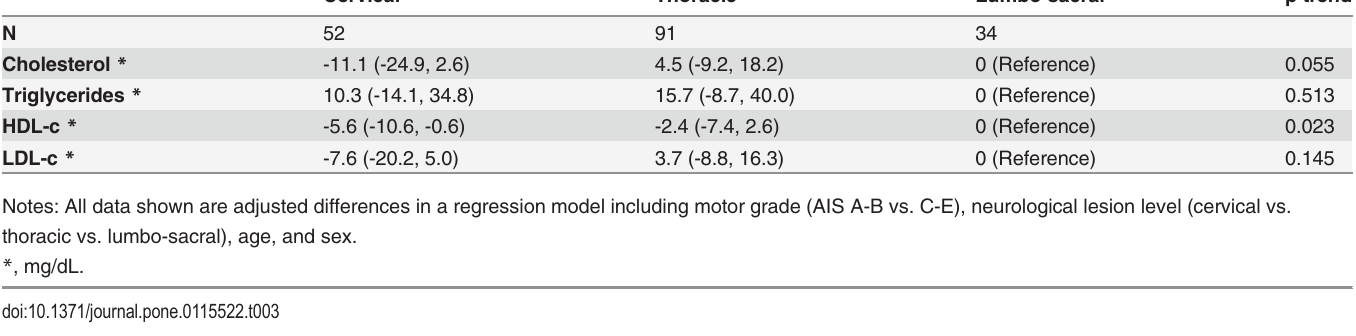
Age- and sex-adjusted Z-scores for lipid values in SCI cases with respect to the reference Spanish population revealed below-normal lipid concentrations for all fractions (Table 5). Conversion to the equivalent values in mg/dL confirmed that SCI cases had lower serum con- centrations of all lipids than the general population: -29.3 mg/dL cholesterol, -58.2 mg/dL triglycerides, -10.4 mg/dL HDL-c, and -4.6 LDL-c. These differences were more pronounced for the most severe condition (AIS A-B individuals with proximal damage) (Table 5 and S2